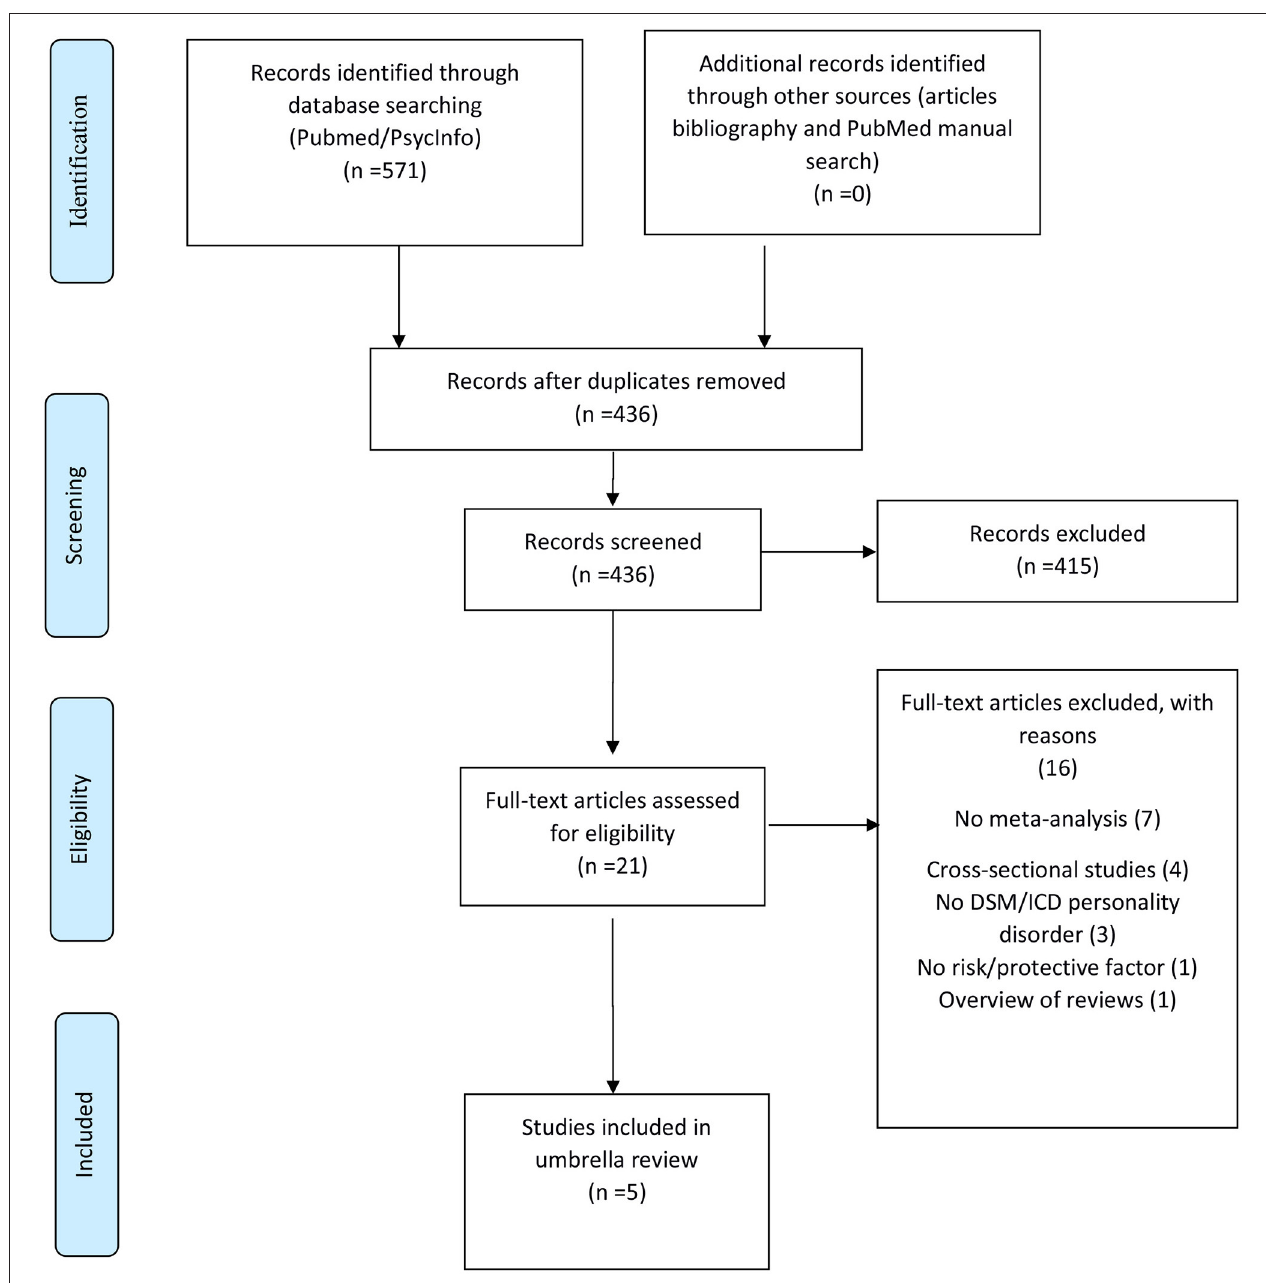
FIGURE 1 | PRISMA flow chart, last search August 31,